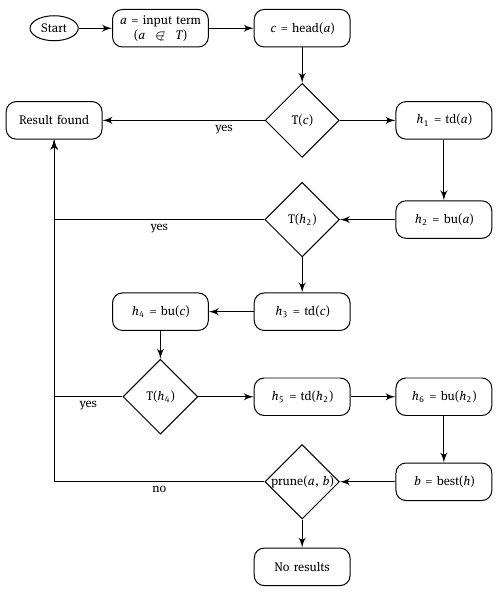
Figure 2: A flow-diagram of the central